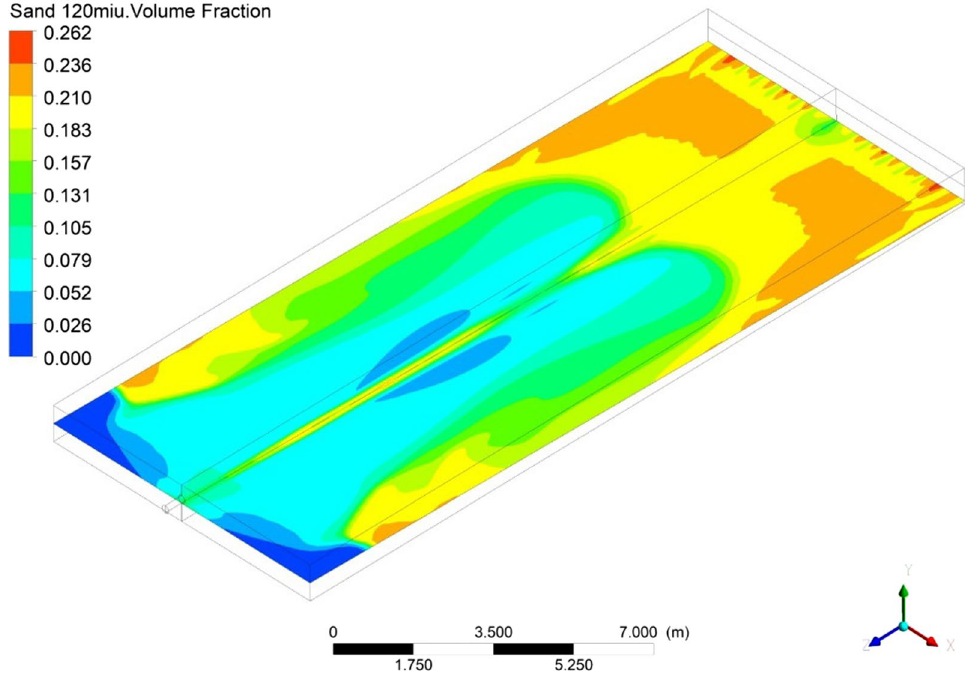
Fig. 11 Volume percentage of 120 μm sediment at 81.515